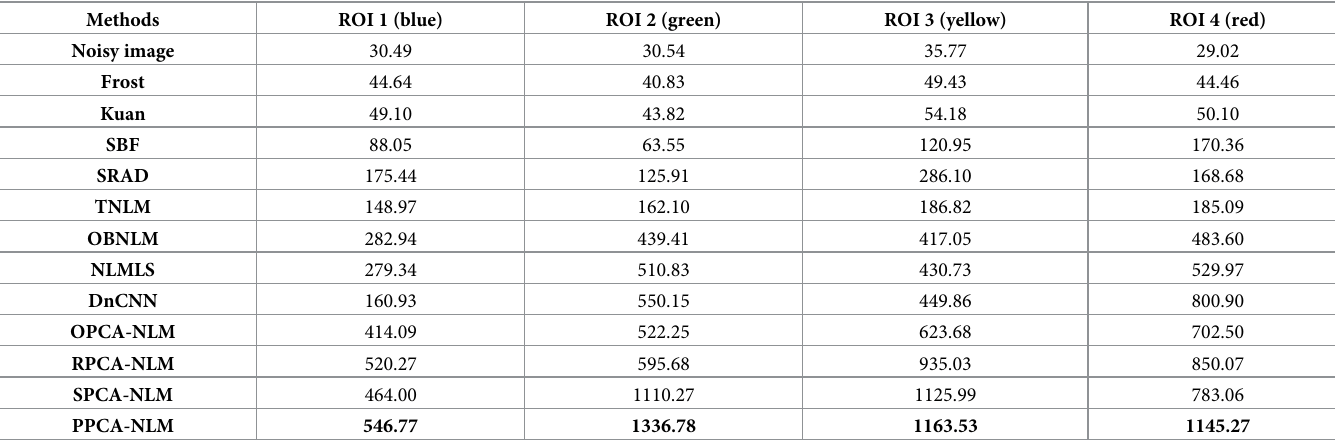
Table 3. The ENL values of four ROIs on the simulated ultrasound image. Methods